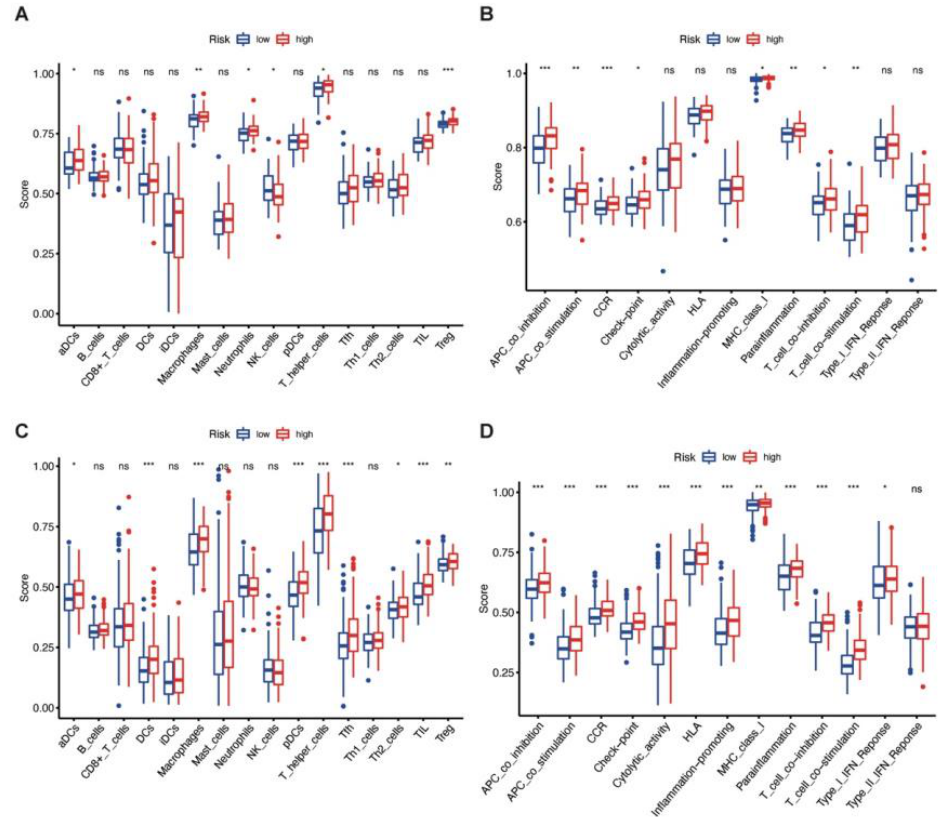
Figure 5. ssGSEA score of immune microenvironments and functions between high-risk and low-risk groups. ( A , C ) Composition of tumor-infiltrating immune cell types of high-risk and low-risk groups in TCGA ( A ) and CGGA ( C ). ( B , D ) Distribution of immune function and relevant pathways of high-risk and low-risk groups in TCGA ( B ) and CGGA ( D ). ssGSEA: single sample gene set enrichment analysis. Blue and red dot: outliner records; *: p < 0.05; **: p < 0.01; ***: p < 0.001.